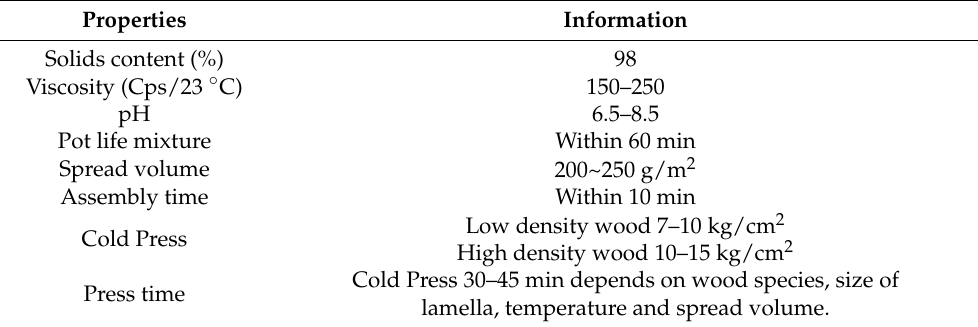
Table 2. The properties of isocyanate adhesive in this study. Properties